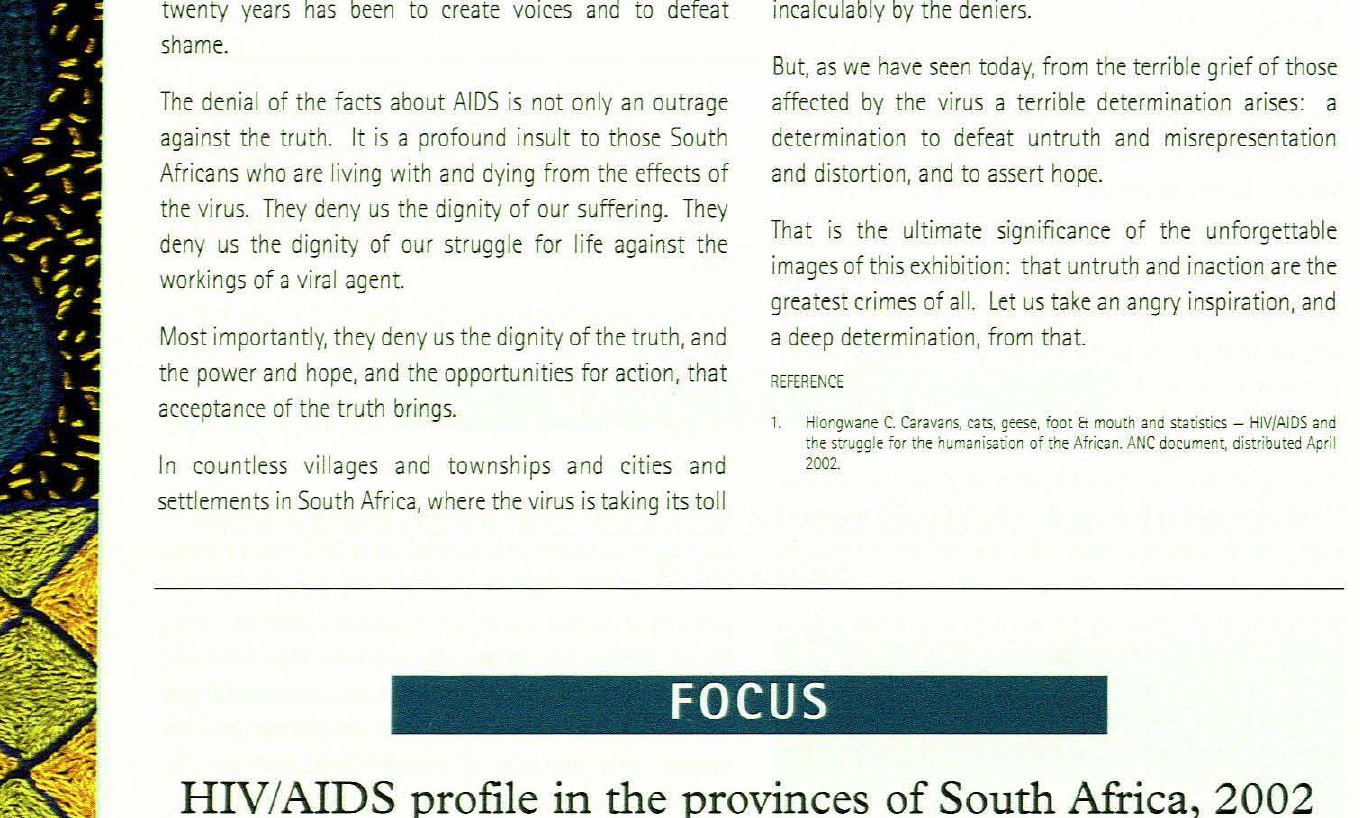
HIV/AIDS profile in the provinces of South Mrica,